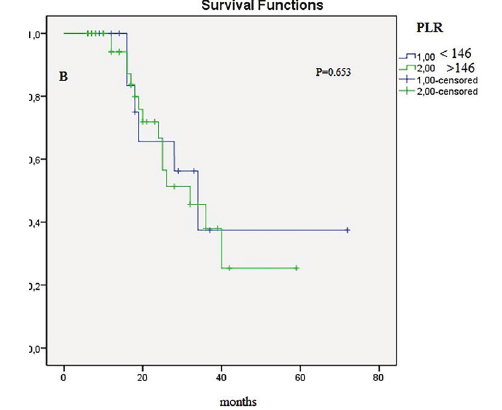
Figure 2B .-Kaplan-Meier curve for PLR